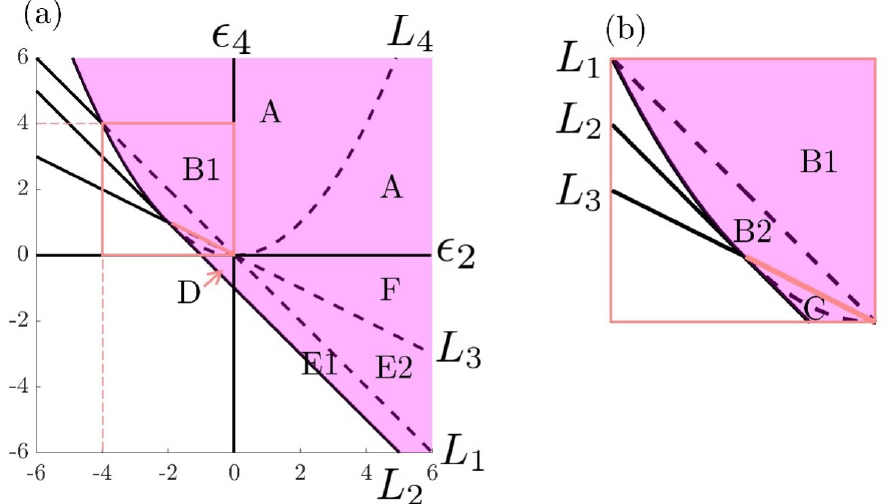
Figure 3. ( a ) Stability diagram of the Rapini–Papoular Equation (2) presented in the parametric anchoring energy space ( (cid:101) 2 , (cid:101) 4 ) . ( b ) A zoom-in plot of the pink square ( − 4 < (cid:101) 2 < 0, 0 < (cid:101) 4 < 4) in ( a ). L 1 to L 4 are critical curves separating different stable zones, where the local surface energy density shows various landscapes summarized and characterized in Table 1. Table 1. A summary of local energy density extrema in the sub-regions presented in Figure 3. Regions in Figure 3 Local Minimum Local